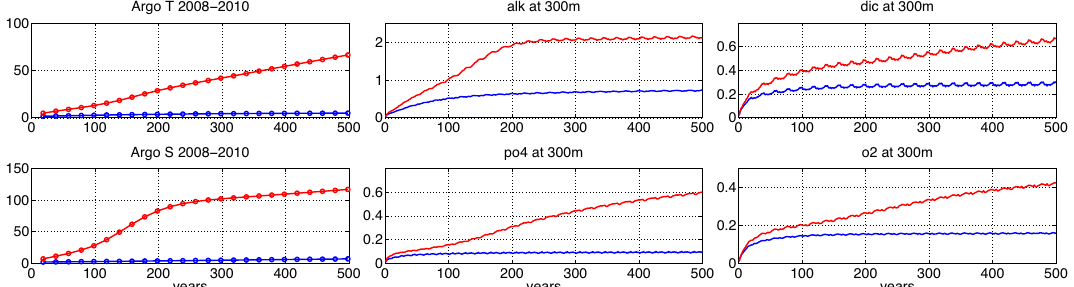
Figure 3. The long-term model drifts away from the observed state gauged by repeated comparison with Argo profiles collected over 2008– 2010 (top left: T ; bottom left: S ) and independent climatological data for biogeochemistry (middle and right panels) in simulations with (blue) the K gm , K σ and K d estimated parameter maps or (red) the K gm , K σ and K d constant first guess parameters. Each plotted value is a cost function d 2 /σ 2 where d is a model–data difference, σ is an uncertainty estimate, and the overbar denotes averaging over all data points. Values of one would indicate model–data differences that are on average exactly at the estimated level of uncertainty. Argo cost function details are reported in Forget et al. (2015). The biogeochemistry model is from Dutkiewicz et al. (2005) with settings provided by H. Song (personal communication, 2015). The corresponding cost functions compare annual mean biogeochemistry model fields at 300m with the climatologies that were used to initialize the model. The 300m climatology standard deviation is further used as an ad hoc uncertainty estimate to form a cost function. Top middle: alkalinity (Key et al., 2004); bottom middle: phosphate (Garcia et al., 2010); top right: dissolved inorganic carbon (Key et al., 2004); bottom right: dissolved oxygen (Garcia et al., 2010).